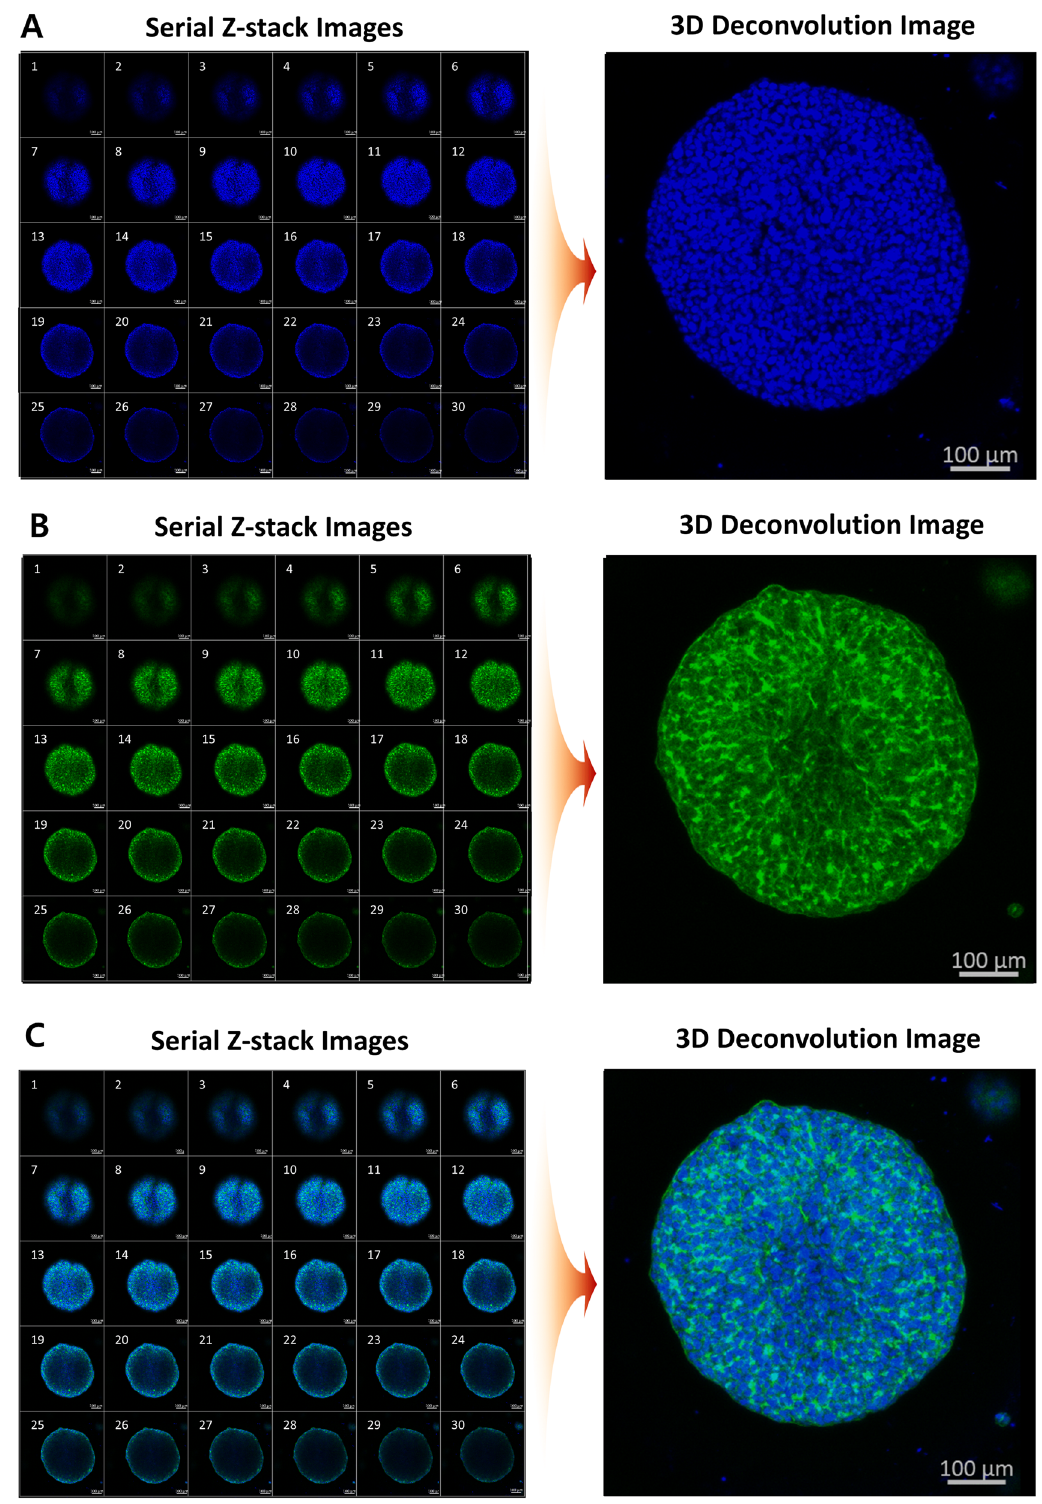
Figure 4. Confocal image scan and 3D deconvolution image implementation for 3D-ASM. ( A ) Serial Z-stack confocal imaging and 3d deconvolution image implementation after cell nucleus staining (blue). ( B ). Serial Z-stack confocal imaging and 3d deconvolution image implementation after cytoskeletal staining (green). ( C ). Implementation of serial Z-stack confocal image and 3d deconvolution image by merging cell nucleus and cytoskeleton images (blue and green